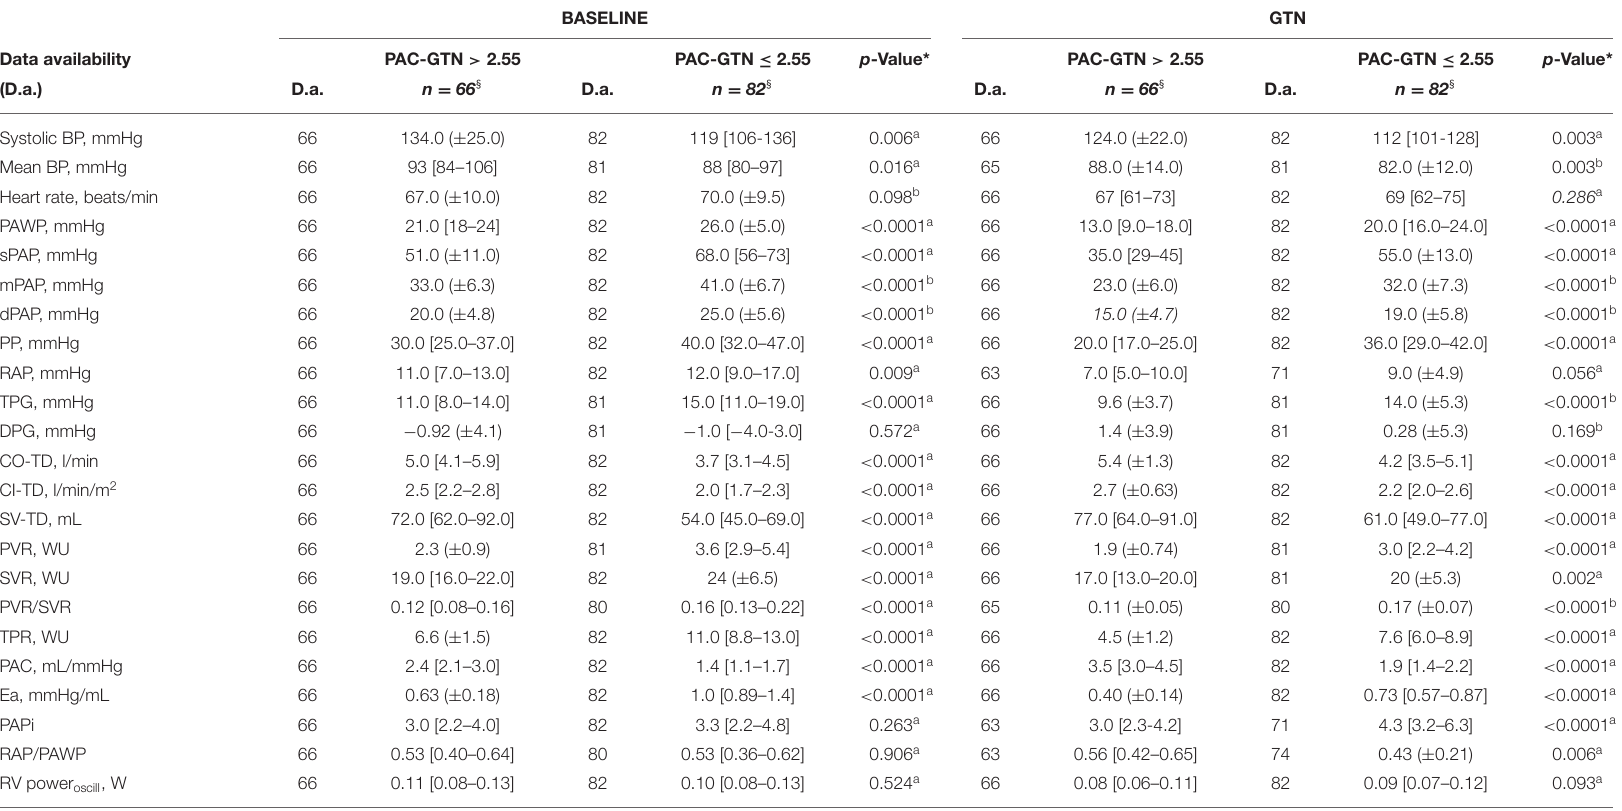
TABLE 2 | Hemodynamics at baseline and after GTN